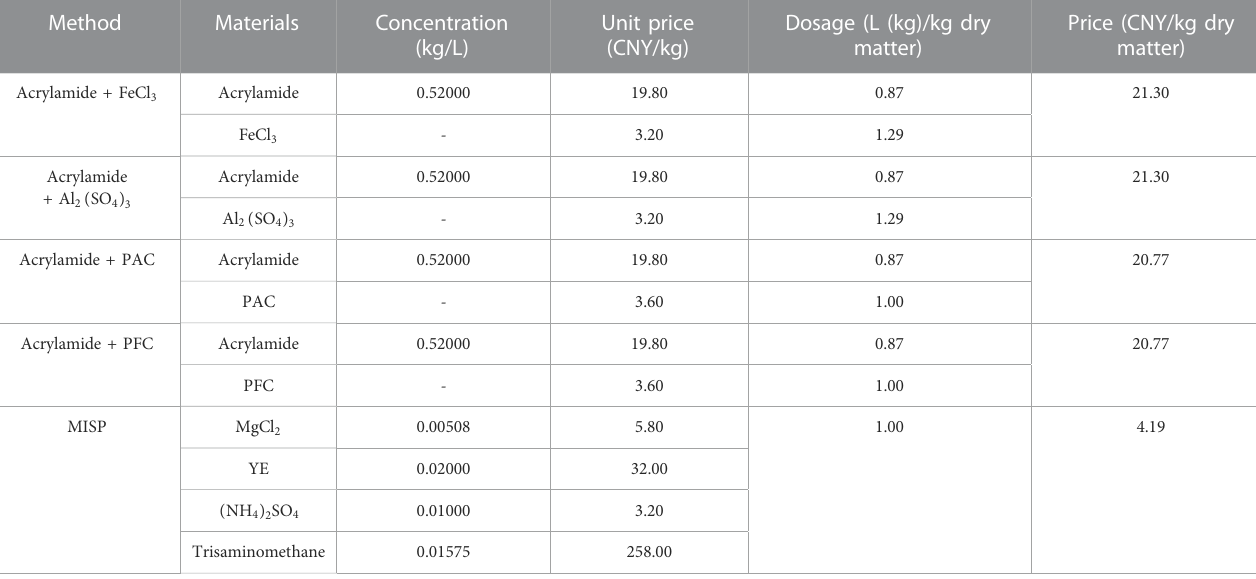
TABLE 3 Cost at current market value a and dosage of fl